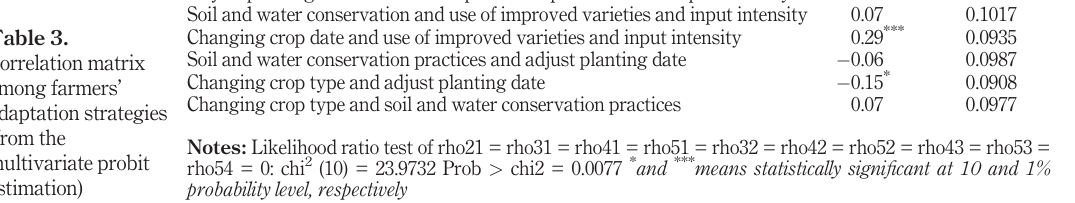
Climate change adaptation